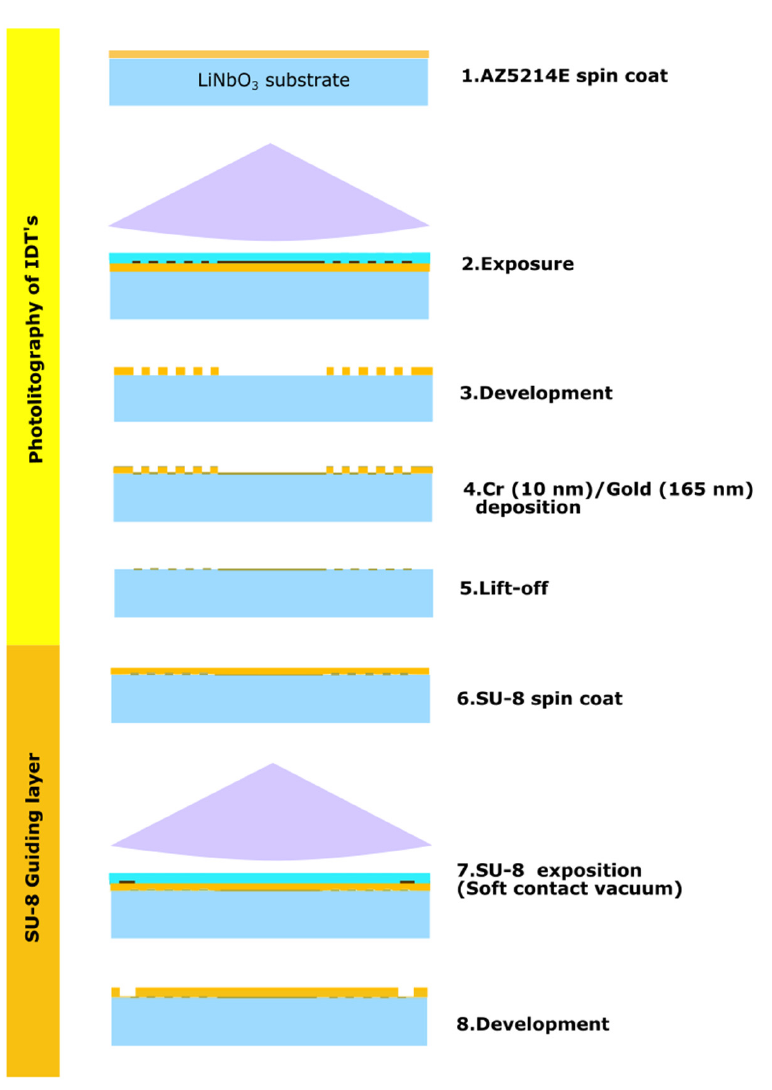
Figure 4. Microlithography fabrication process of the Love wave sensor. Steps for IDTs and metal- lization fabrication, followed by steps for SU-8 guiding layer coating and connection pad release. Parameters for the fabrication are shown in Tables 4 and 5.